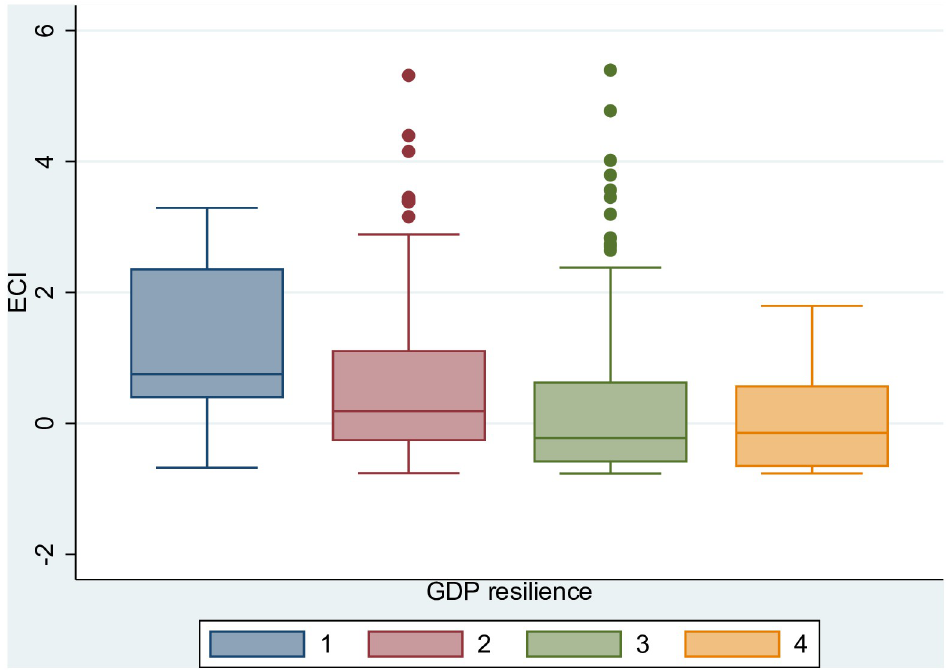
Fig 14. GDP resilience and ECI. GDP resilience measured using the index developed by ESPON [69]: 1 = resistant to the economic crisis; 2 = recovered from the economic crisis; 3 = not recovered but experienced economic upturn; 4 = not recovered and still experiencing economic downturn. The figure has been generated using StataSE